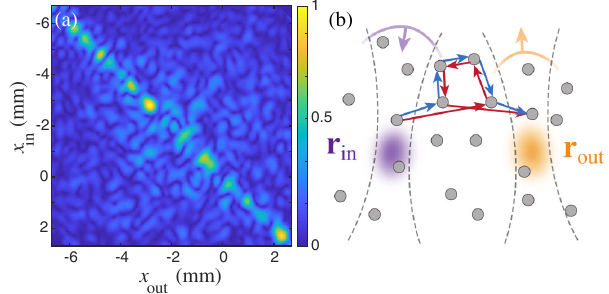
FIG. 4. (a) The modulus of matrix R xx is shown at depth z ¼ 44 . 5 mm. Signals from multiple scattering can be seen at elements far from the diagonal. (b) Sketch of multiple-scattering paths (red or blue path) involved in the matrix R xx . The constructive interference between reciprocal paths (red and blue paths) occurs only when j r out − r in j < δ x